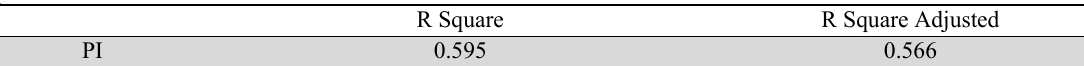
Hypothesis Result